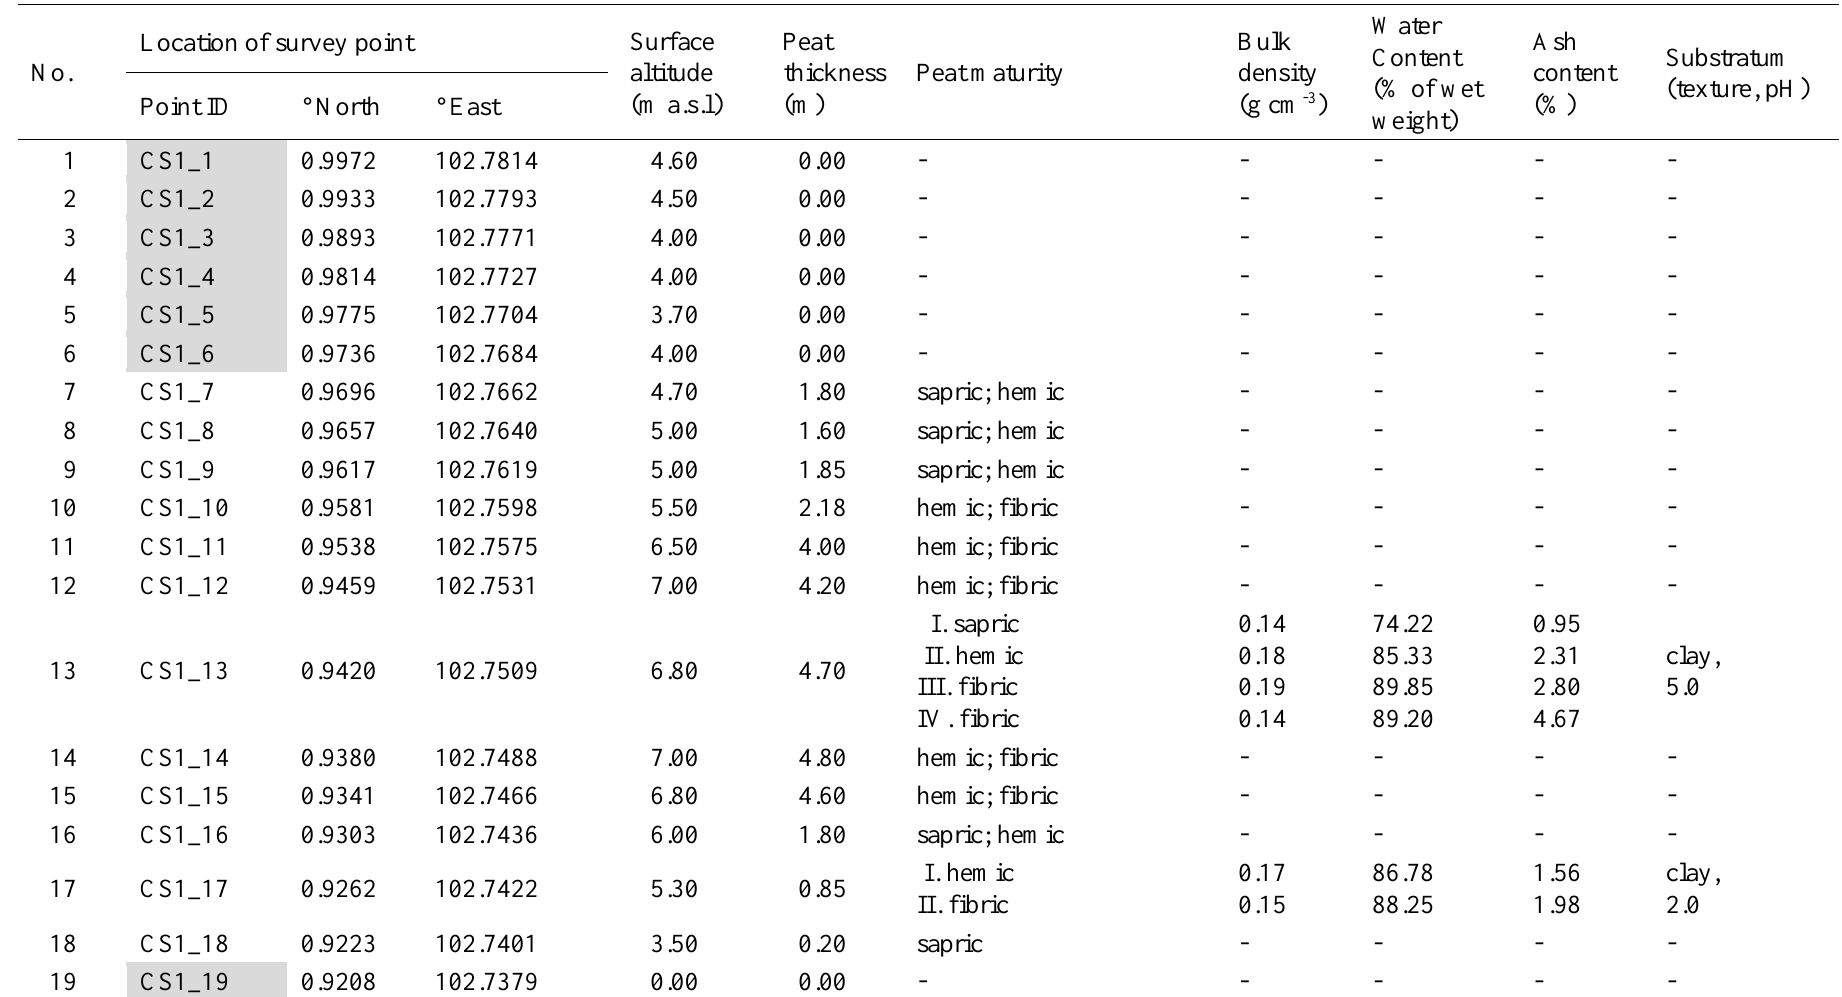
Table A1. Locations of survey points and data collected for characterisation of peat thickness and of the mineral substratum. Shaded cells indicate survey points without peat that were eliminated from the statistical